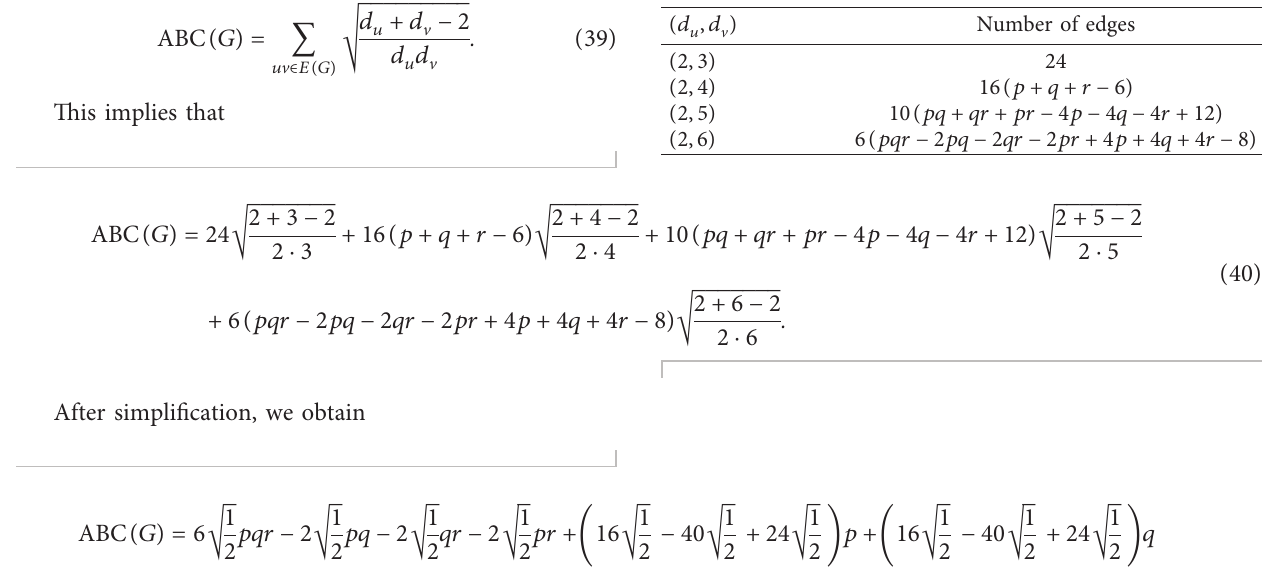
Figure 5: The unit cell of rhenium trioxide lattice ReO . 3 Table 7: Edge partition of RO ( p, q,r ) centered on degree of final (end) vertices of each edge, where uv ∈ E ( G )